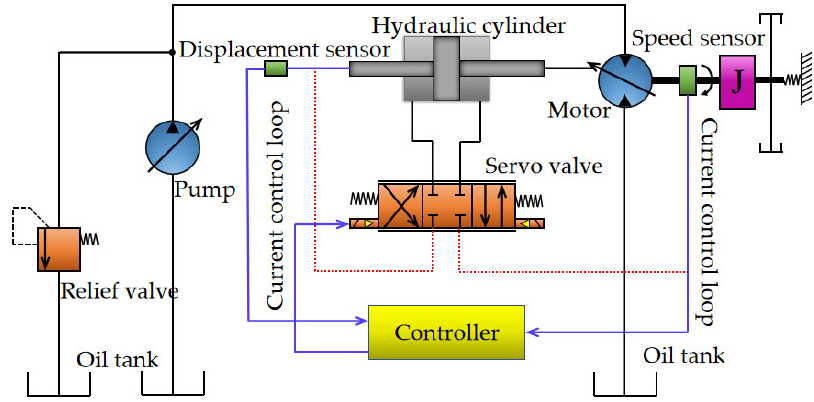
Figure 1. Schematic diagram of PMSS. Table 2. Key components of PMSS operating parameters.